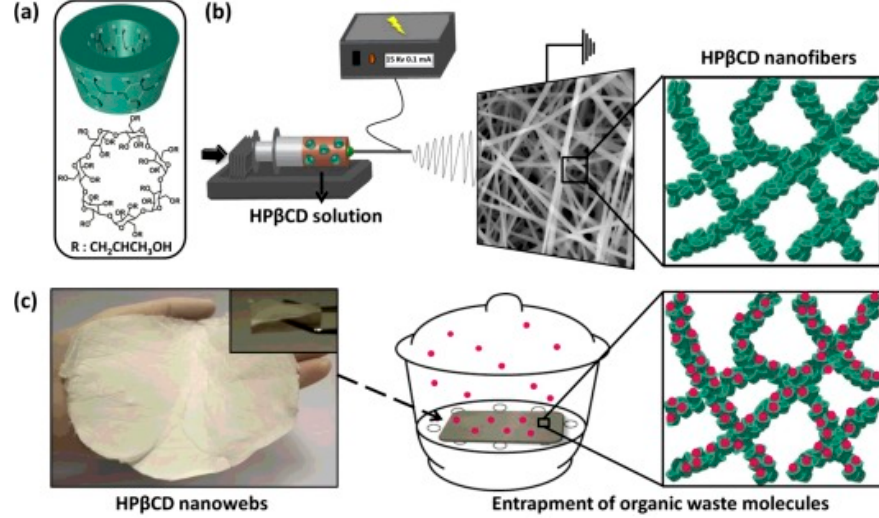
Figure 6. HP β CD solution ( a ) was electrospun to obtain polymer free-fibers ( b ). The obtained mats ( c ) were cut as pieces of 100 mg and exposed to vanillin and benzene vapors inside a desiccator (30 cm diameter × 30 cm height) for 12 h. Reproduced from [34] with permission from Elsevier.